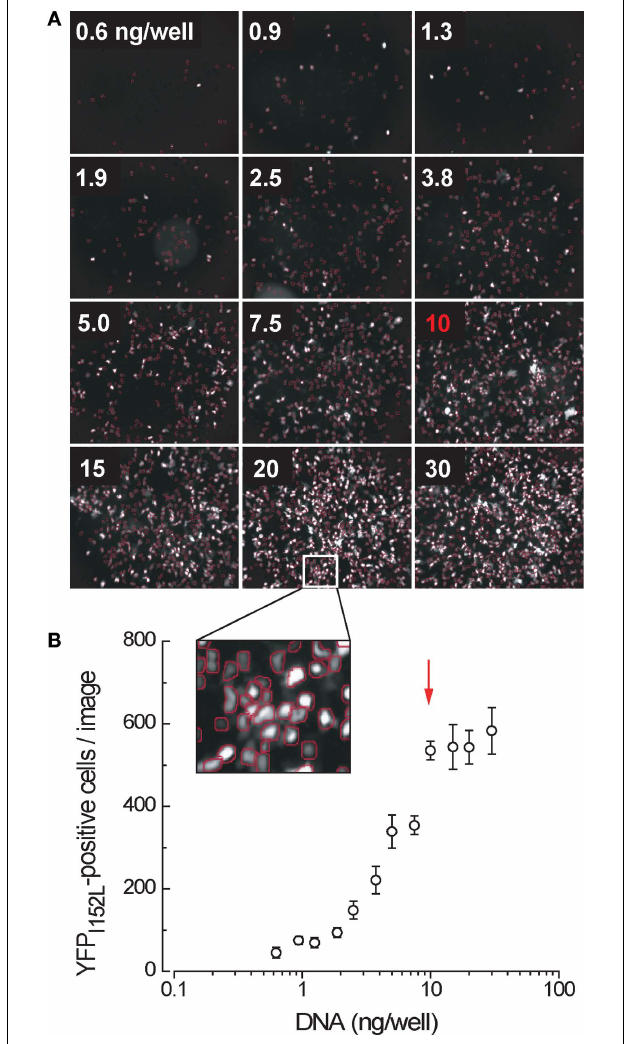
FIGURE 3 | Yellow fl uorescent protein expression in cells transfected in single wells of a 384-well plate as a function of the amount of cDNA transfected. (A) Sample results from a single experiment. All wells contained an equivalent number ( ∼ 5000) of cells. (B) Mean number of fl uorescent cells per image, averaged from four independent experiments. Arrow denotes point of optimal transfection effi